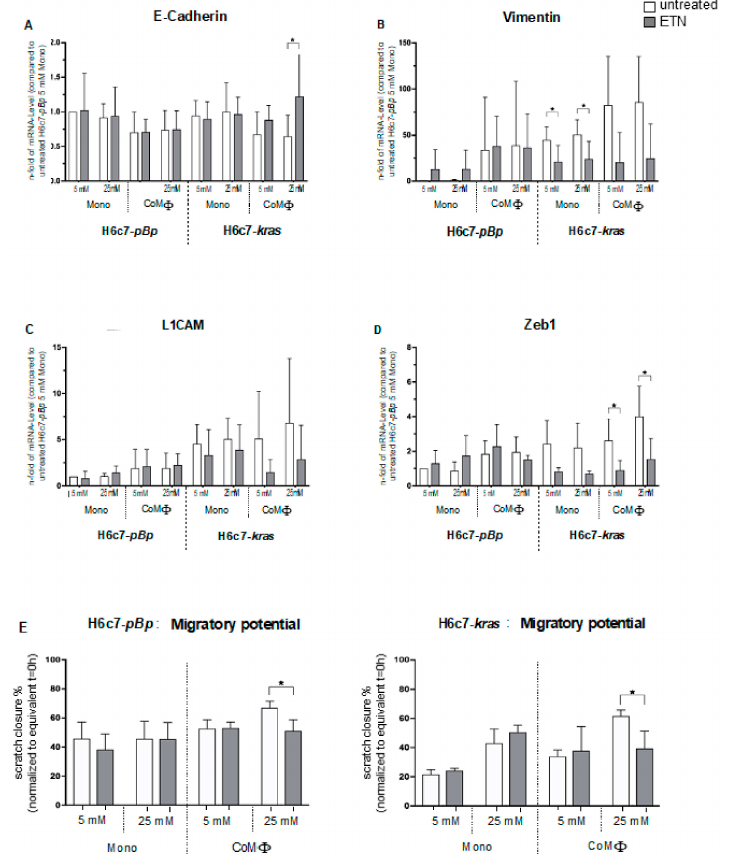
Figure 8. Neutralization of TNF- α reverses the effects of M1 macrophages and hyperglycemia on the EMT phenotype in H6c7- kras cells. CFSE-stained H6c7- pBp or H6c7- kras cells were cultivated in mono- or coculture with M1-polarized macrophages (M Φ ) under normo- or hyperglycemic conditions (5 or 25 mM of D -glucose). Blockade of TNF- α activity was achieved by treatment with 10 µ M Etanercept (ETN). As control, cells were left untreated. The epithelial cells were separated from direct coculture via CD11b-MACS depletion of M1-M Φ and used for qPCR analysis. The relative mRNA levels of E- cadherin ( A ), Vimentin ( B ), L1CAM ( C ) and Zeb1 ( D ) are depicted, normalized to the housekeeping gene GAPDH and presented as n -fold expression compared with the respective population of monocultured H6c7- pBp cells in 5 mM glucose medium without ETN. Normally distributed data are presented as mean and standard error of mean; n = 9 ETN; n = 3 +ETN. In ( E ) the migratory (cid:31) potential of PDEC mono- or cocultured with M1-M Φ under both glucose conditions with or without ETN treatment is shown. For this, PDEC were stained with CFSE and macrophages with CellTrace TM Violet, and a scratch assay was performed using the NyONE Cell Imager. Scratch closure was recorded at t = 0 h and t = 16 h for H6c7- pBp cells as well as t = 0 h and t = 8 h for H6c7- kras cells and data are presented as % scratch closure. Normally distributed data are presented as mean and standard error of mean; * p < 0.05; n =